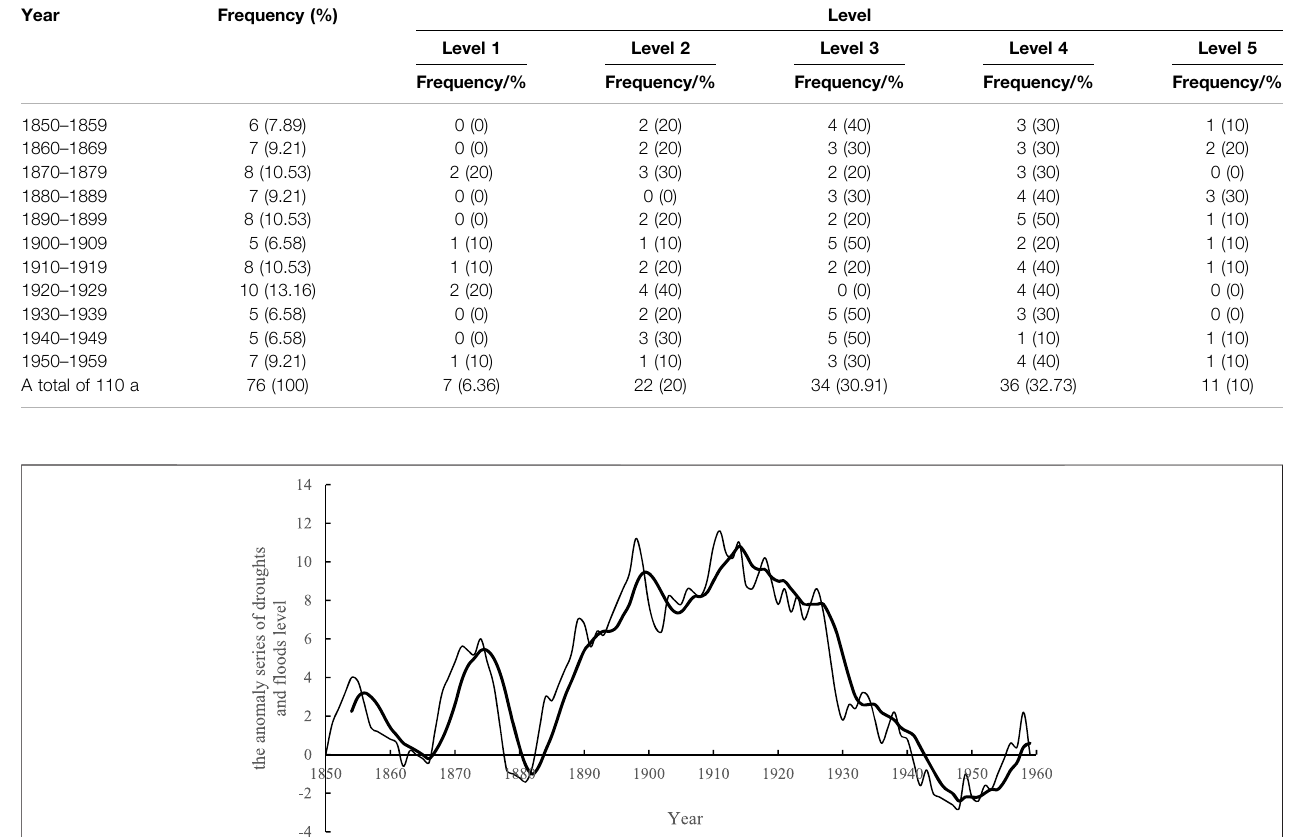
TABLE 3 | The drought and fl ood level frequency in the Qinling Mountains from 1850 to 1959.